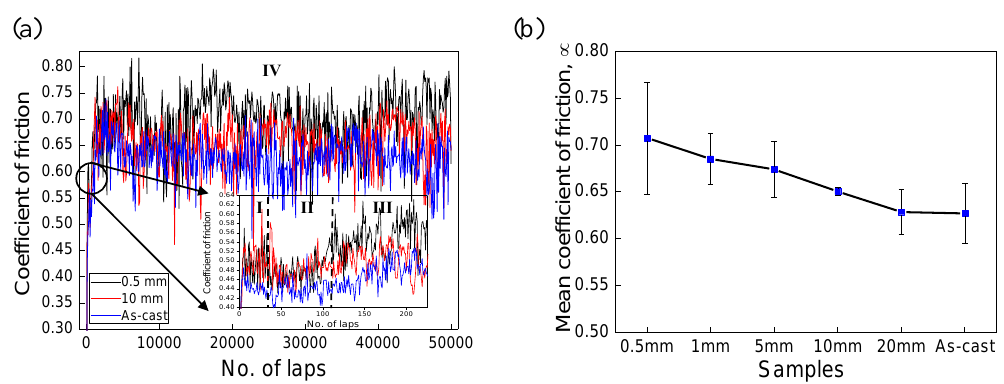
Figure 9. ( a ) COF curves of Ti64 samples as a function of number of sliding laps. ( b ) Mean COFs of EBM-built and as-cast Ti64 samples.